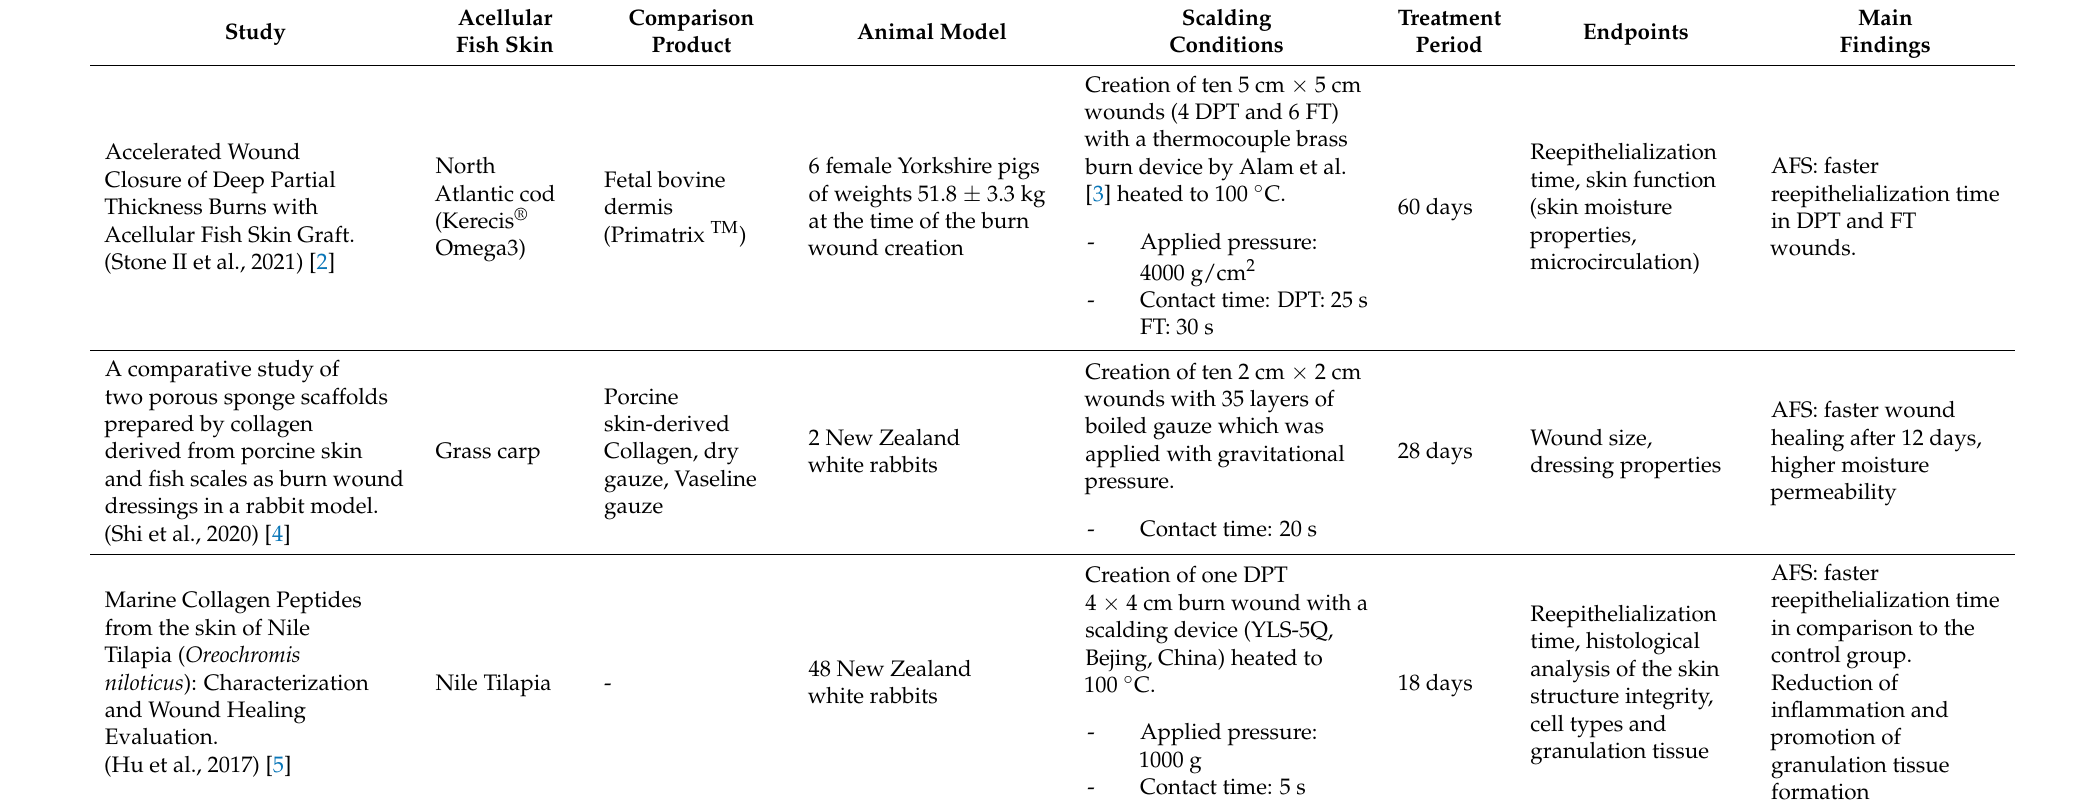
Table 1. Preclinical studies evaluating the use of acellular fish skin in burn